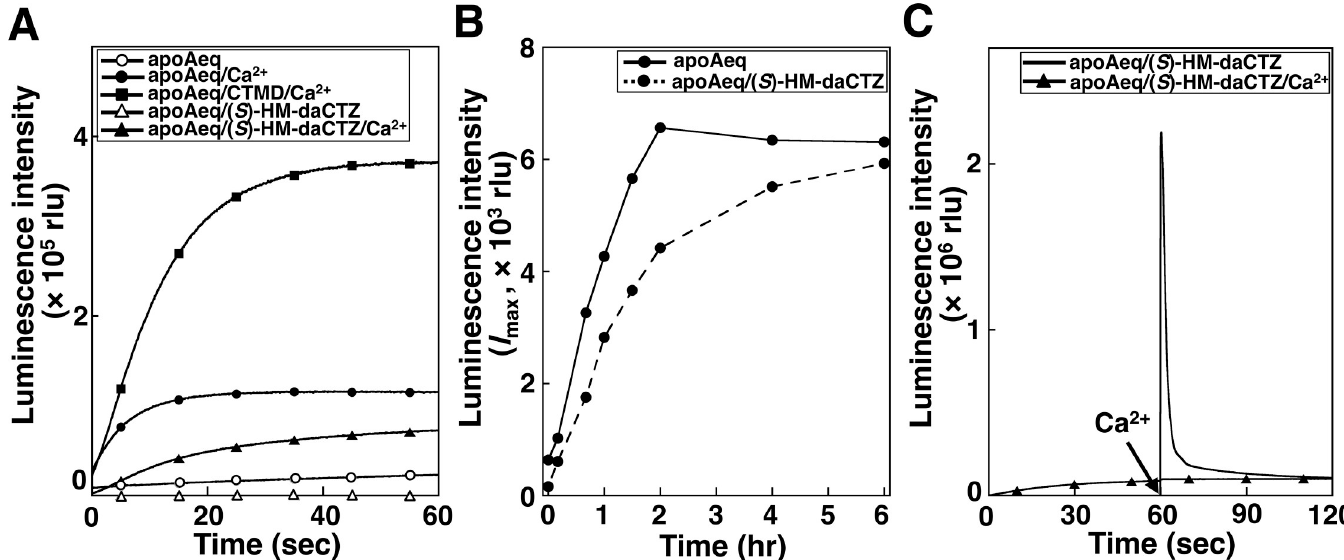
Fig 7. Luminescence properties of the apoAequorin/( S )-HM-daCTZ complex, by comparison with apoAequorin. A. Comparison of the luciferase-like luminescence reaction of the apoAequorin/( S )-HM-daCTZ/Ca 2+ complex with the complex of apoAequorin, coelenteramide (CTMD), and Ca 2+ . The reaction mixture contains 1 μ g of apoAequorin in 100 μ L of Tris-HCl (pH 7.6) in the presence of 10 mM CaCl 2 , 1 μ g/ μ L of CTMD, and/or 1 μ g/ μ L of ( S )-HM-daCTZ. The luminescence reaction was started by the addition of 1 μ g/ μ L of coelenterazine at 22˚C and the luminescence activity was determined using a luminometer. B. Time course of aequorin regeneration from the apoAequorin/( S )-HM-daCTZ complex with coelenterazine. The regeneration conditions are the same as in Fig 5A. The luminescence activity of 5 μ L in the mixture was determined using a luminometer with a 0.23% neutral density filter. The bold line and dashed line indicate apoAequorin and the apoAequorin/( S )-HM- daCTZ complex, respectively. C. Ca 2+ -triggered luminescence reaction of aequorin regenerated from the apoAequorin/( S )-HM-daCTZ complex and coelenterazine. The mixture includes 1 μ g of apoAequorin or the apoAequorin/( S )-HM-daCTZ complex in 1 mL of 30 mM Tris-HCl (pH 7.6)–10 mM EDTA containing 1 μ g/ μ L of coelenterazine and 1 μ L of 2-mercaptoethanol and incubated at 4˚C. The luminescence activity of 1 μ L of regenerated aequorin was determined by injection of 100 μ L of 50 mM CaCl 2 using a